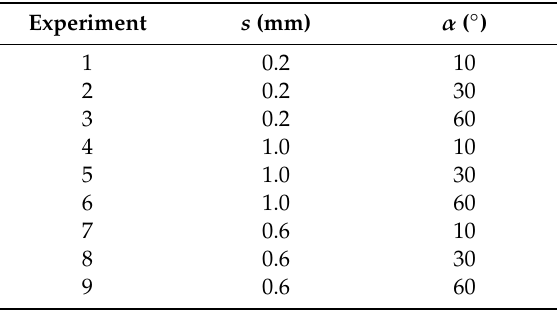
Table 6. Three-level division of conventional trochoidal milling experiments.